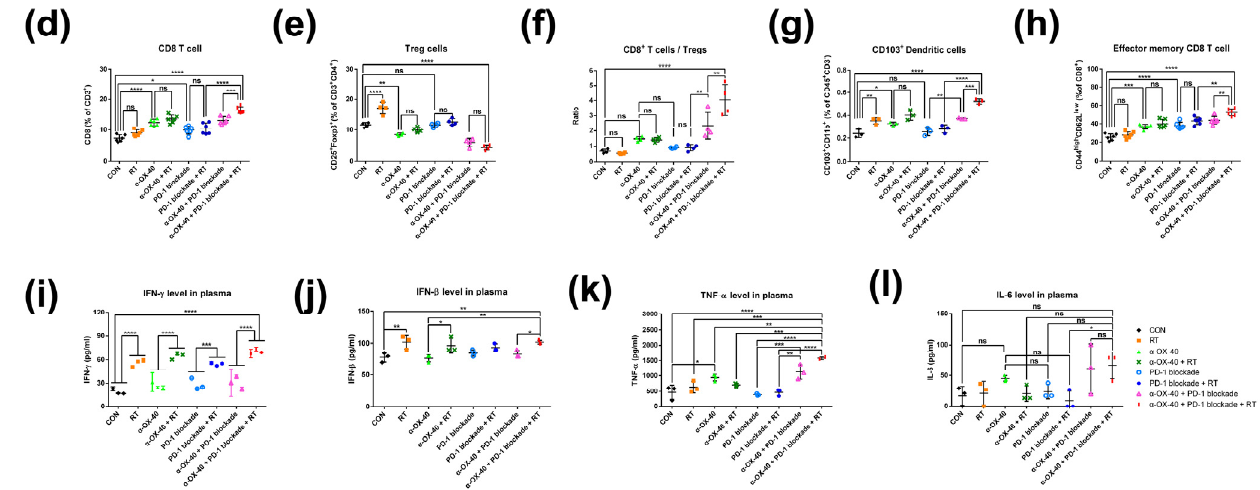
Figure 2. Immune cell profiles in the spleen. Representative flow cytometry plots for ( a ) CD4+ or CD8+ T cells, ( b ) CD4 + FOXP3+ Tregs, and ( c ) CD45 + CD103+ dendritic cells. ( d – h ) Cell population percentages calculated from flow cytometry analyses. ELISpot quantification of ( i ) IFN- γ , ( j ) IFN- β , and ( k ) TNF- α plasma levels. ( l ) Cytometric bead array results for IL-6 plasma levels. * p < 0.05, ** p < 0.01, *** p < 0.001, **** p < 0.0001. Abbreviations: CON, control; RT, radiotherapy; Treg, regulatory T cell; DC, dendritic cell; ns, not significant.